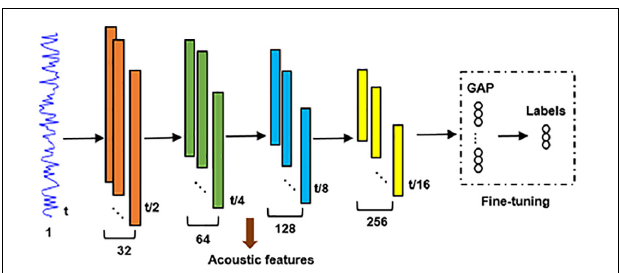
FIGURE 3 | The architecture of the supervised DNNs for audio classification. GAP, global average